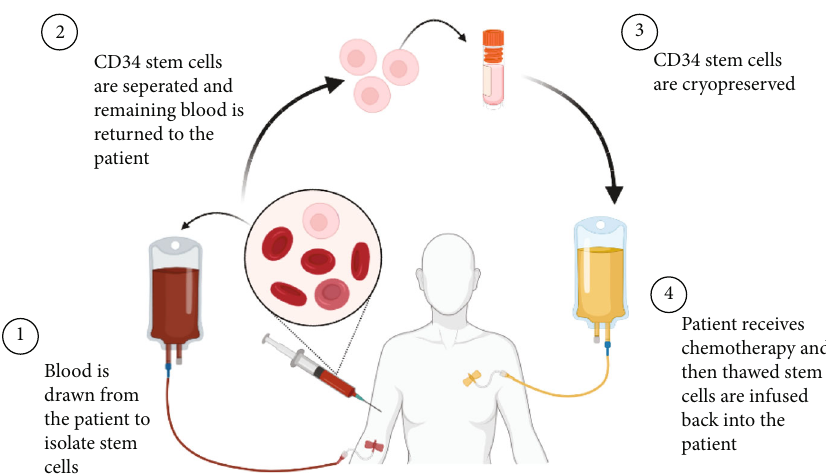
Figure 3: CD34 cell therapy overview. The patients ’ blood is drawn and CD34 positive cells are isolated and expanded in culture before cryopreservation. The CD34 cells can be infused back into the patient after they receive